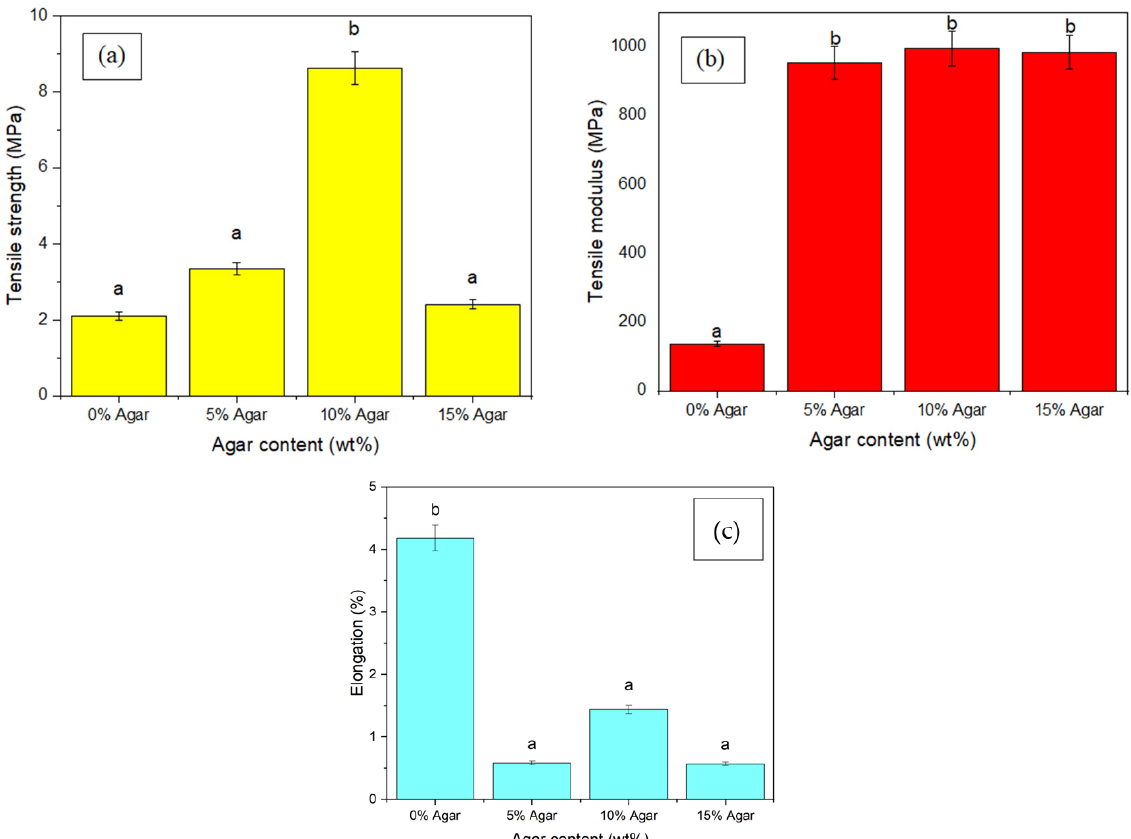
Figure 5. ( a ) Tensile strength, ( b ) tensile modulus, and ( c ) elongation at break (%) for TPSS/agar. Letters a and b in the figure indicate groups in homogenous subset which has p <